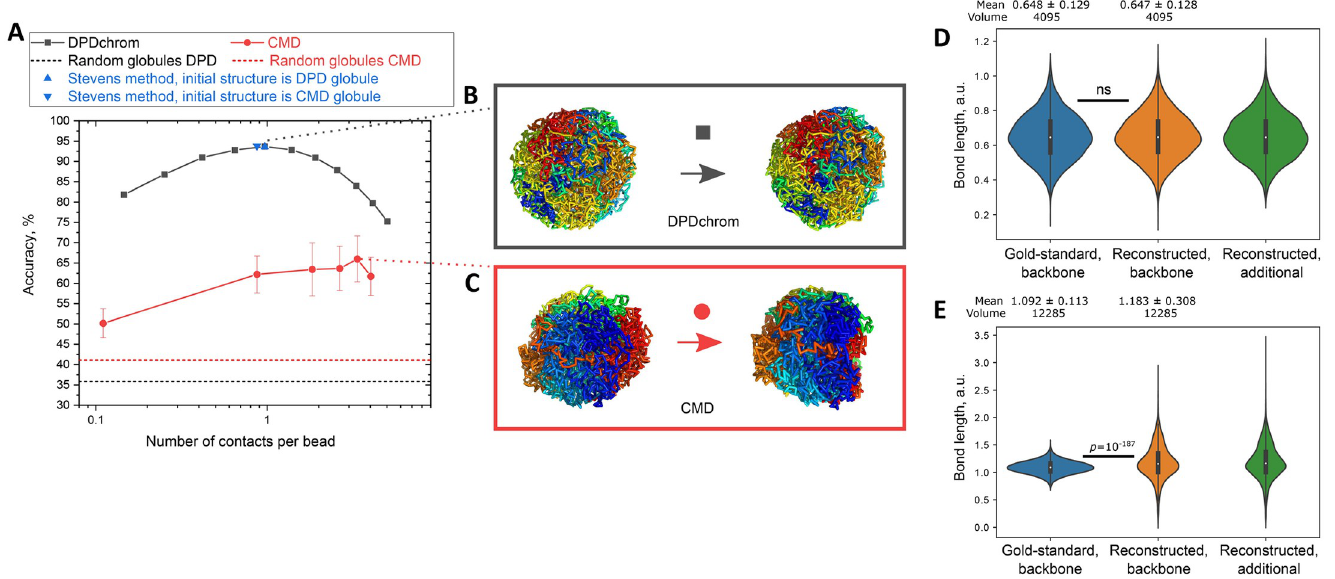
Fig 2. A . Dependence of the reconstruction accuracy on the number of contacts per bead for DPDchrom, CMD, and the Stevens method. The dashed lines represent the degree of similarity of two random polymer globules obtained by DPD and CMD, respectively. B, C . The gold-standard (left) and the best reconstructed (right) conformations. The chains are colored by rainbow from the first bead to the last one. D, E . The bond length distributions of the gold-standard conformation and those reconstructed by DPDchrom (D) and CMD (E). For the reconstructed conformations, the backbone bonds and the additionally introduced bonds from the gold- standard contacts are represented